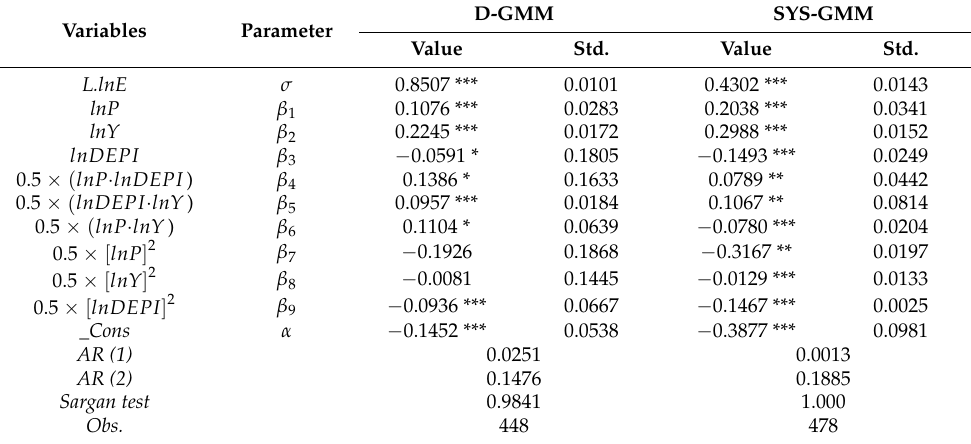
Table 2. Parameter estimation